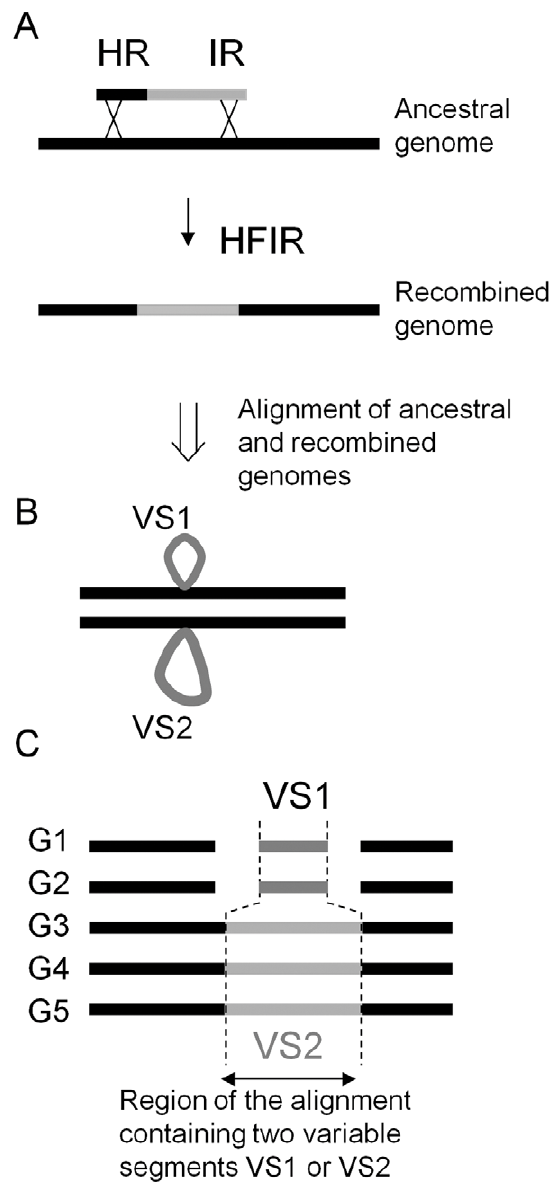
Figure 1. HFIR may account for the occurrence of insertions coupled with deletions, observed upon multiple genomes alignments. A . During Homology-Assisted Illegitimate Recombination (HFIR), a linear fragment sharing homology with the chromosome (black part) enters into the recipient chromosome by an atypical double crossing-over event, with homologous recombination (HR) at the left- end of the molecule, and illegitimate recombination (IR) at the other end. B . Alignment of the resulting recombinant with the ancestral genome will produce two small ‘‘variable regions’’ flanked by the backbone sequences, common to both strains. C . Diversification of strains produced by HFIR, leads to the detection of insertions (variable segment VS2 in genomes G3-G5) coupled with deletions (variable segment VS1 in genomes G1-G2) upon multiple genome alignments of various E. coli strains (here 5